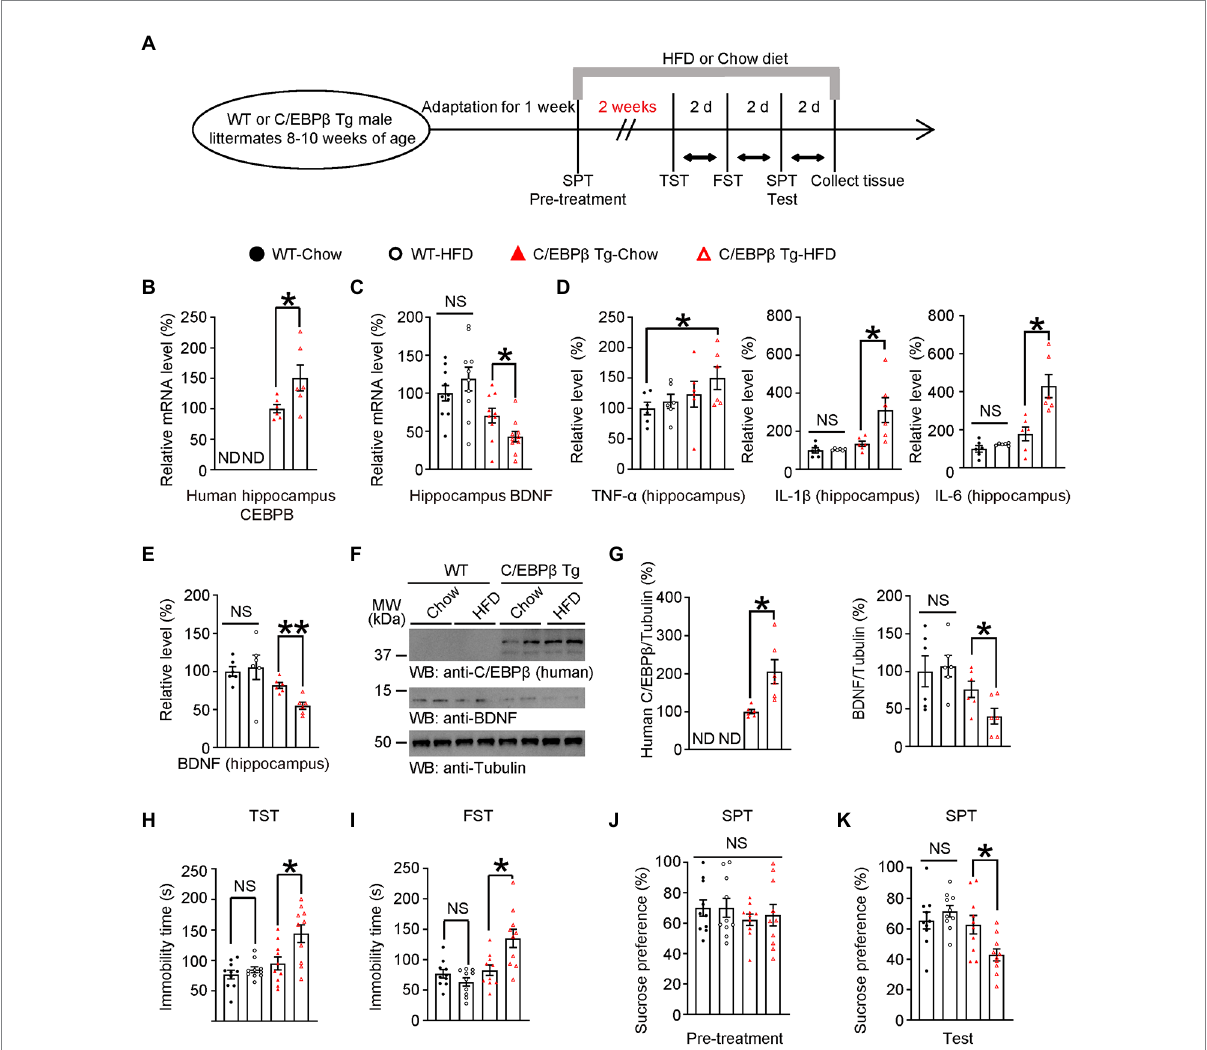
FIGURE 4 A short-term HFD induces depression-like behaviors in Thy1-C/EBP β transgenic mice. (A) Schematic of the short-term HFD or chow diet course and behavioral tests process. HFD, high-fat diet; TST, tail suspension test; FST, forced swim test; SPT, sucrose preference test; d, day. (B,C) qRT- PCR analysis of (B) CEBPB and (C) its downstream target BDNF in the hippocampus of wild-type and Thy1-C/EBP β transgenic mice fed with a chow diet or HFD. Data in (B) represent the mean ± SEM ( n = 6 for each group; * p < 0.05; ND, not detected; unpaired t -test with Welch’s correction). Data in (C) represent the mean ± SEM ( n = 10 for each group; * p < 0.05; NS, not significant; one-way ANOVA and Bonferroni’s multiple comparison test). (D,E) ELISA assay results for (D) inflammatory cytokines and (E) BDNF in the hippocampus lysates. Data represent the mean ± SEM of six samples per group from three independent experiments (* p < 0.05, ** p < 0.01; NS, not significant; one-way ANOVA and Bonferroni’s multiple comparison test). (F,G) Immunoblotting from hippocampus lysates of wild-type and Thy1-C/EBP β transgenic mice fed with a chow diet or